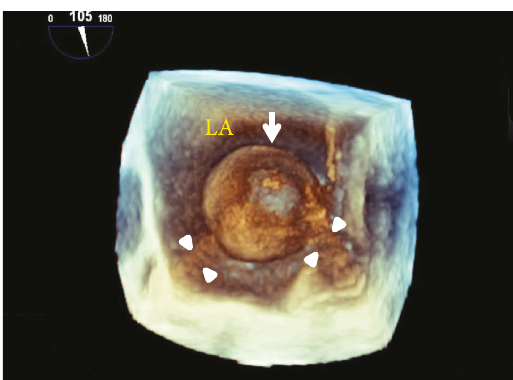
Figure 3: Three-dimensional transesophageal echocardiographic image of the free- fl oating ball-shaped mass (arrow) around which some sludge (arrow heads) is present suggesting a potential mechanism of its formation. Abbreviations are the same as in Figure 2.